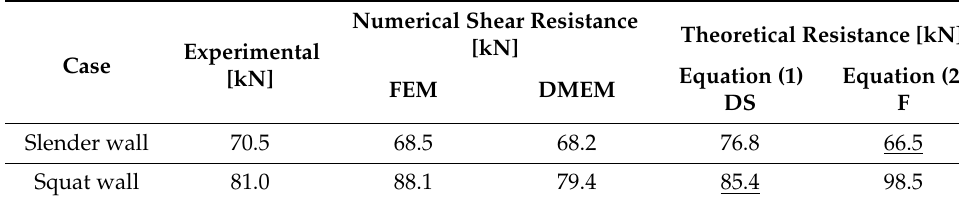
Table 2. Comparison between experimental, numerical and analytical values of the shear resistance.